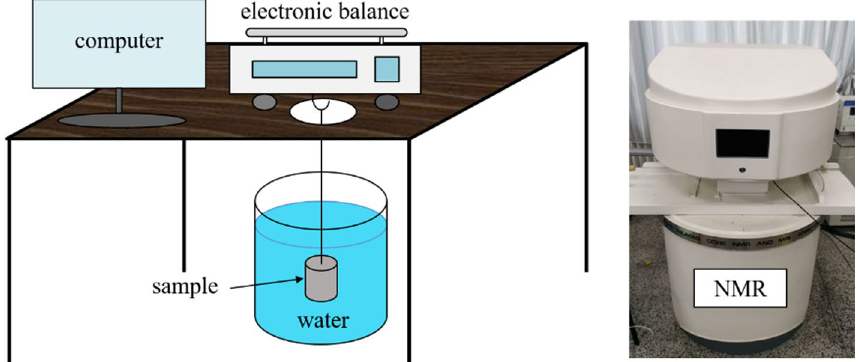
Fig. 4 Schematic diagram of SI experiment and NMR instru- ment